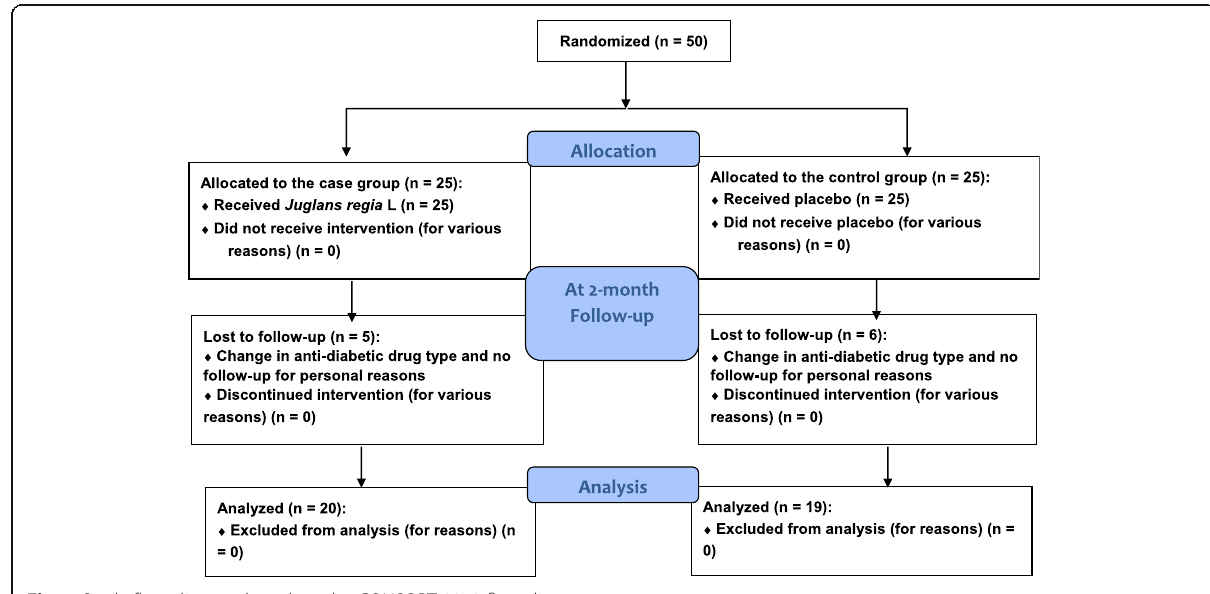
Fig. 1 Study flow diagram based on the CONSORT 2010 flow